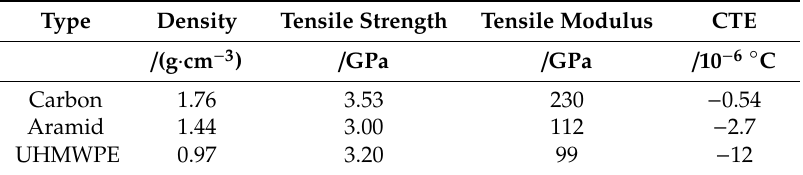
Figure 1. MBWK structure with three layers of inserting yarns. Table 1. Specification of inserting yarns.